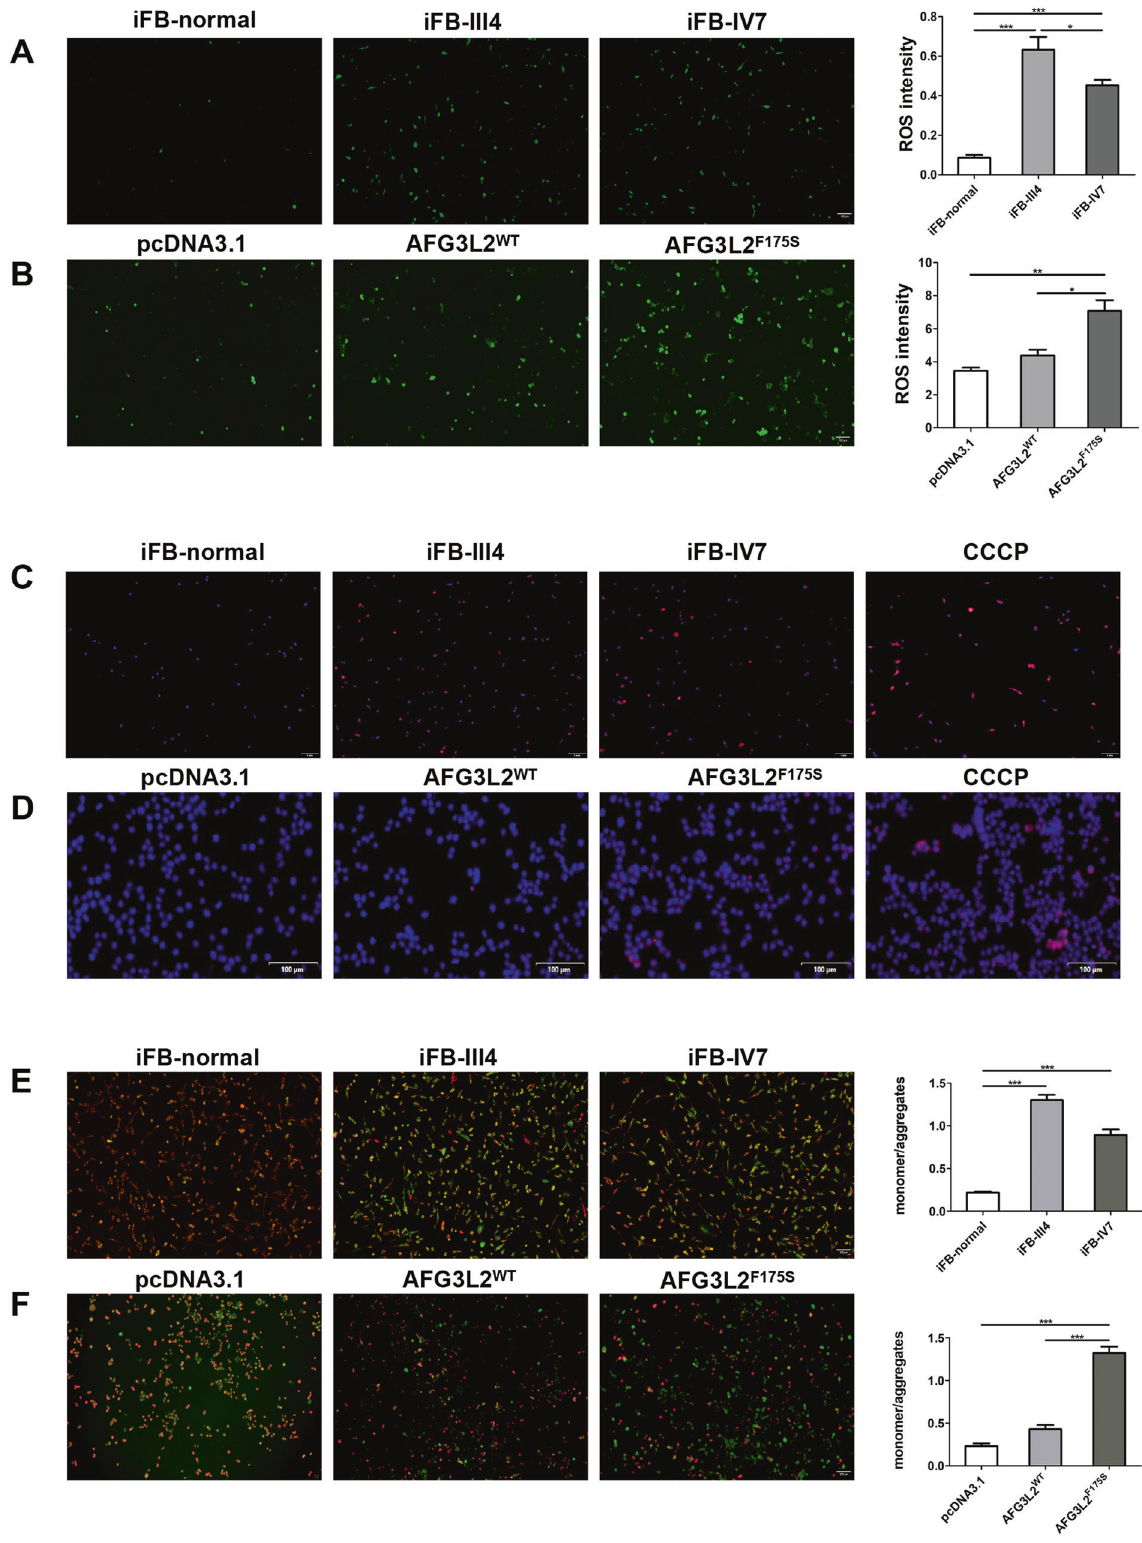
Fig. 3 F175S mutation caused mitochondrial damage. A , B The cytoplasmic ROS staining (green) in human normal and F175S AFG3L2 mutation iFB cells and HEK293T cells. Cell density was shown in Supplementary Fig. 3. C , D The mitochondrial ROS staining (red) in human normal and F175S AFG3L2 mutation iFB cells and HEK293T cells. Cells treated with CCCP were used as positive control. E , F MMP in wild-type and F175S AFG3L2 mutation iFB cells and HEK293T cells. Green fl uorescence and red fl uorescence represent JC-1 monomer and JC-1 aggregates, respectively. Cell transfection ef fi ciency was shown in Supplementary Fig. 4. (Values expressed as mean ± SD, * p < 0.05, ** p < 0.01, *** p < 0.001).